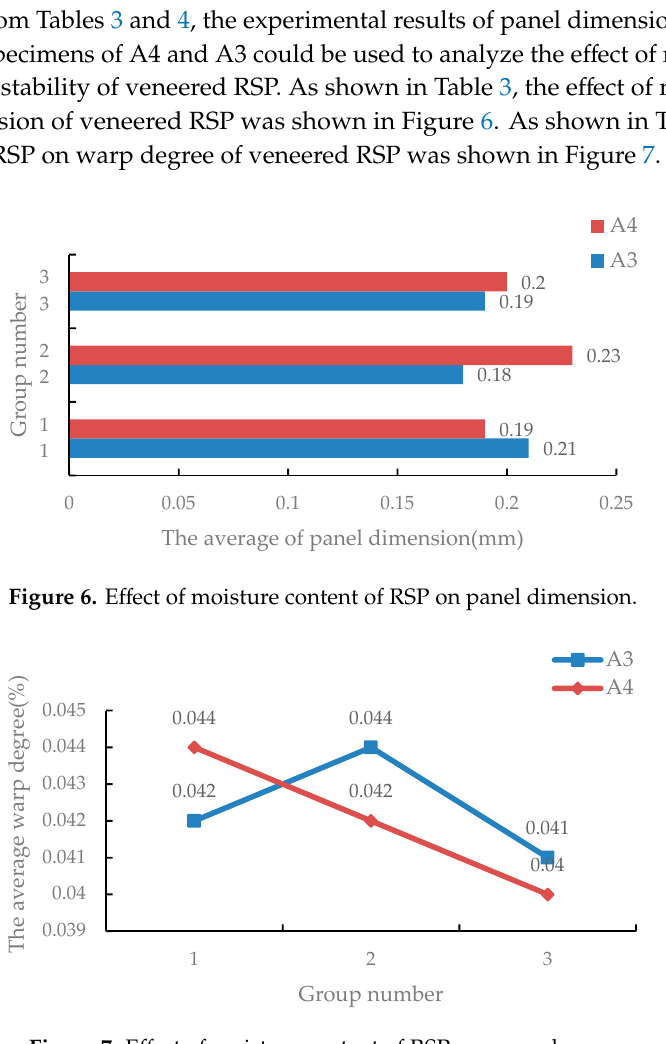
Figure 7. E ff ect of moisture content of RSP on warp Figure 7 . Effect of moisture content of RSP on warp degree. Figure 7 . Effect of moisture content of RSP on warp degree.